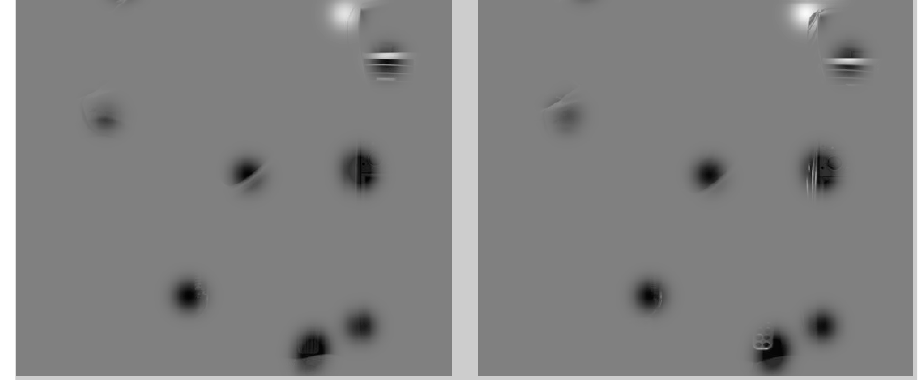
Figure 7: A”Bubbles” paired-wise comparison for 207 car